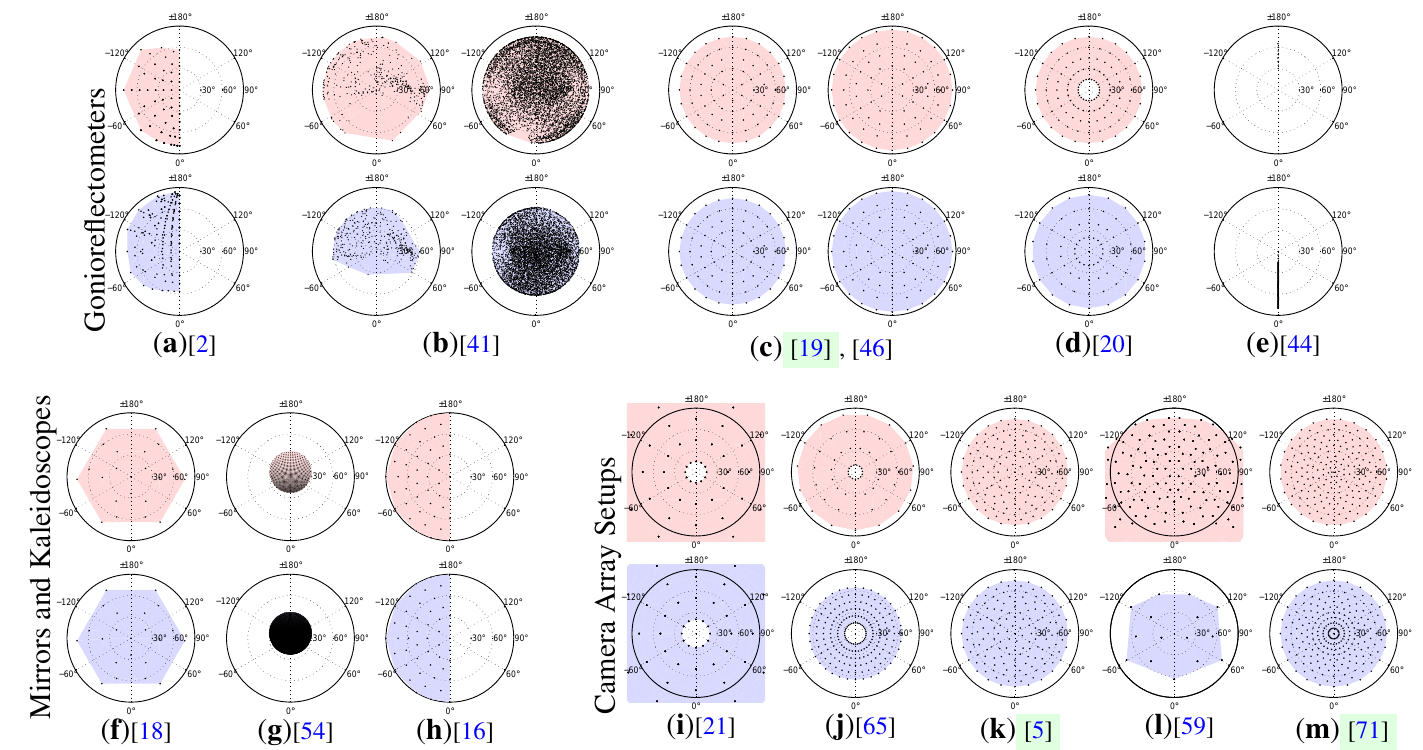
Figure 21. Sampling of the angular domain for selected setups (top disc: light hemisphere; bottom disc: view hemisphere). Our setups are shaded in green. The angle corresponds to φ , the radius to θ . The reported measurement directions ω = ( φ, θ ) are plotted as black dots, shaded regions emphasize the achieved directional coverage for the sake of easy visual comparison. For (b), directions from the two measurements with fewest and most reported samples are shown. In (c), we illustrate both direction samplings from Table 1. Note that Filip et al . [46] adopted the sampling from our setup. The color-shading in (i) and (l) exceeds the plot, because the setups also capture samples at the lower hemisphere. Almost all setups capture the Cartesian product of the indicated view and light directions, i.e. , all possible pairs. In contrast, in (a) and (b), each direction participates in exactly one sample. Many setups do only cover parts of the directions on the hemispheres ((a), (b), (e), (g), (h)), have holes ((d), (i), (j)) or show an extremely sparse sampling ((f), (l)). Our setups ((c), (k), (m)) all have a wide direction coverage with densely and equally distributed